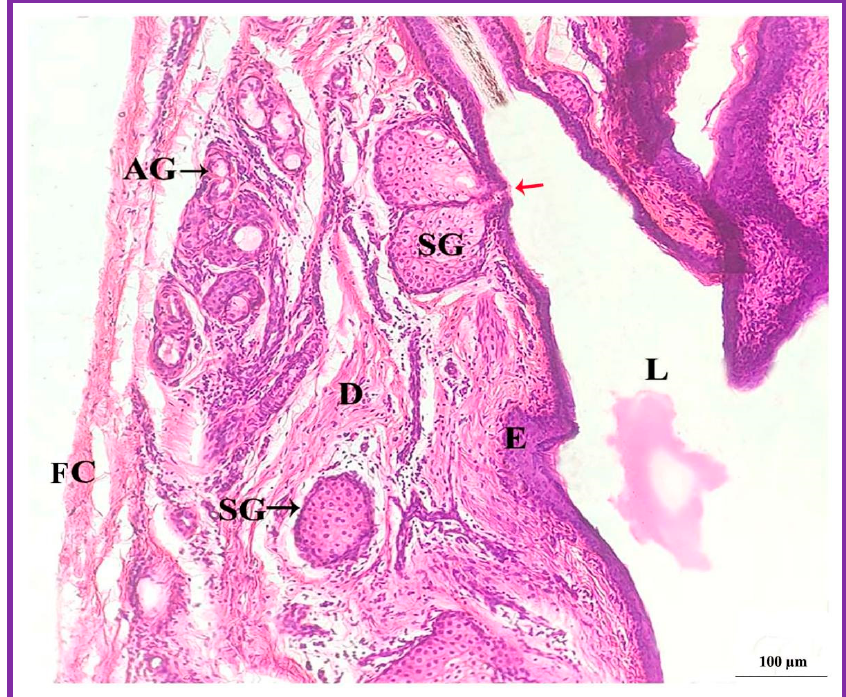
Figure 10. Photomicrograph of the interdigital sinus of male Vembur sheep showing the quite large holocrine sebaceous secretory lobules (SG) compared to apocrine gland (AG). Red arrow: secretion directly discharged into the lumen (L); FC: fibrous capsule; E: epidermis; D: Dermis.